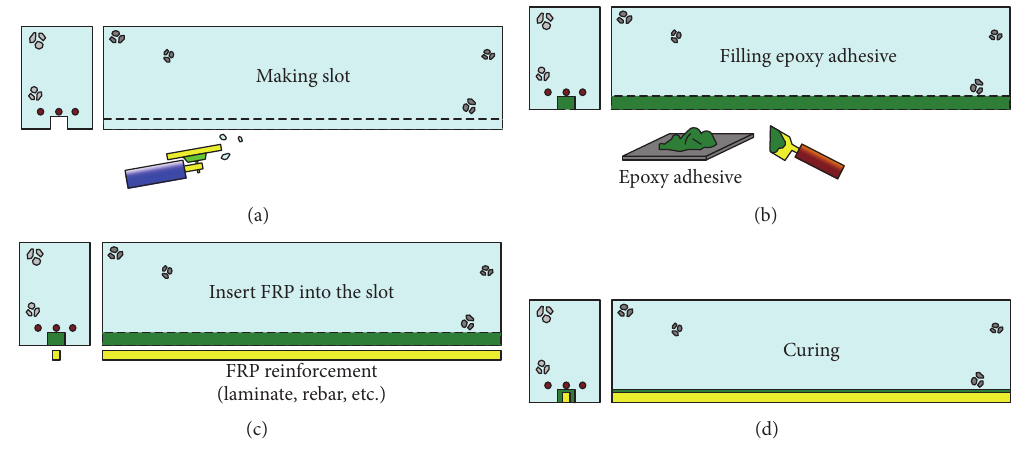
Figure 11: Specimen strengthening process by NSMR.